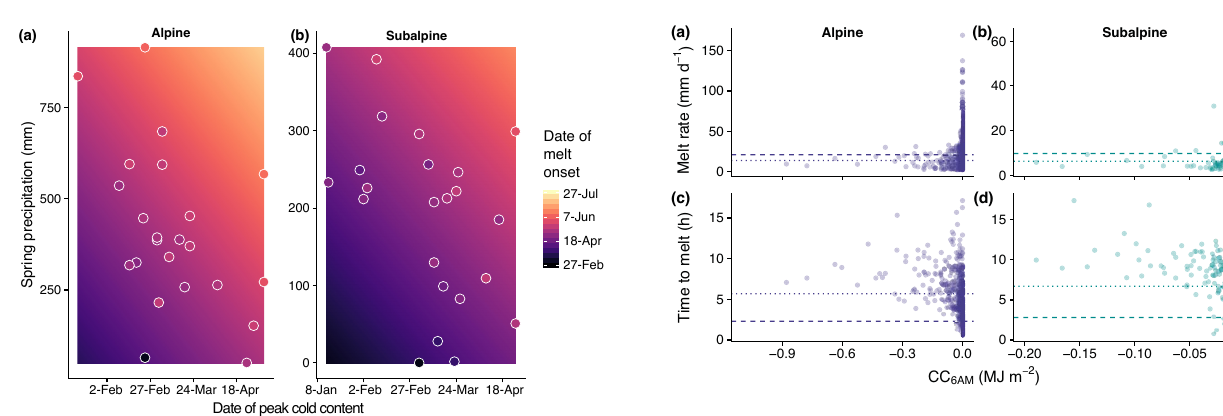
Figure 12. Simulated daily melt rates in the alpine (a) and sub- alpine (b) and time to snowmelt in the alpine (c) and subalpine (d) as a function of CC 06 : 00AM . The dashed line in each figure rep- resents the mean melt rate (a, b) and time to melt (c, d) for days when CC 06 : 00AM = 0MJm − 2 and the dotted line represents those quantities for days when CC 06 : 00AM < 0MJm − 2 .